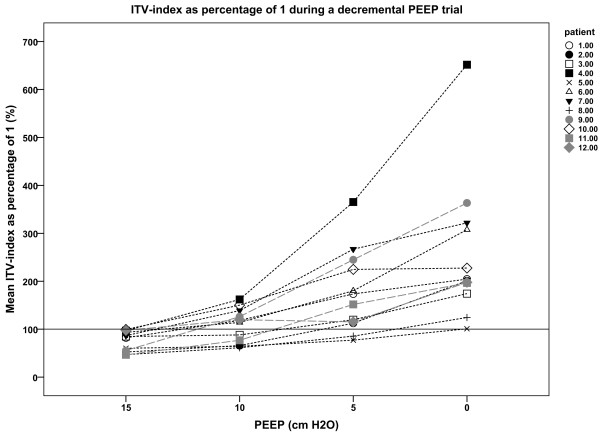
Intratidal gas distribution (ITV) index at varying positive end-expiratory pressure (PEEP) levels for the individual patients. Mean ITV index is shown as a percentage of 1. Here, the value 100% indicates that both lung regions are equally ventilated. Values >100% indicate that ventilation is predominantly distributed to the non-dependent region whereas values <100% indicate that the dependent lung region is predominantly at that PEEP level.